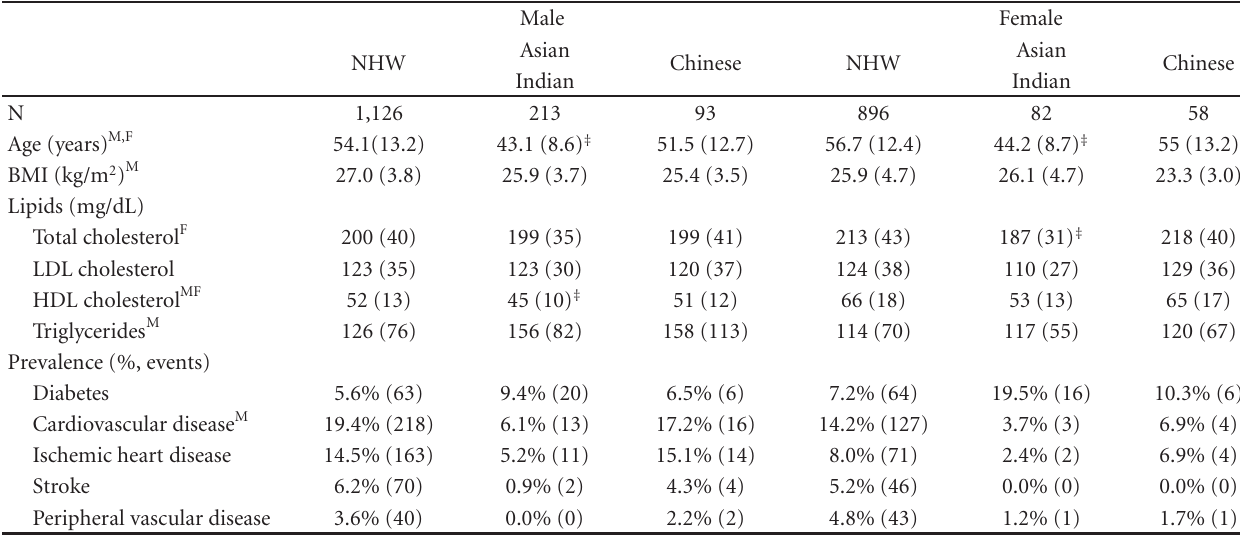
Table 1: Patient characteristics by race/ethnicity and gender.